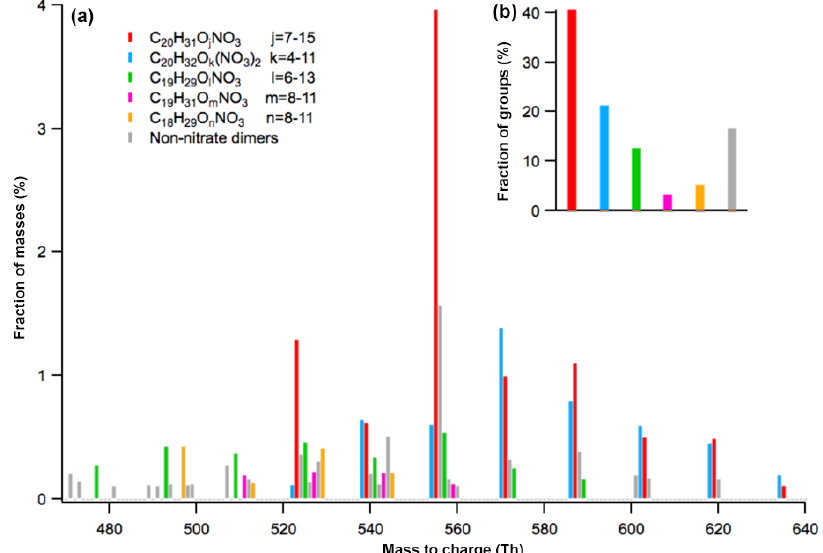
Figure 9. Dimer profile of the nighttime type-2 factor. All dimer peaks are assigned to six groups based on their elemental formula and marked with different colors. Figure 9a shows the location and mass fraction of individual peaks, and Fig. 9b gives the fraction of these